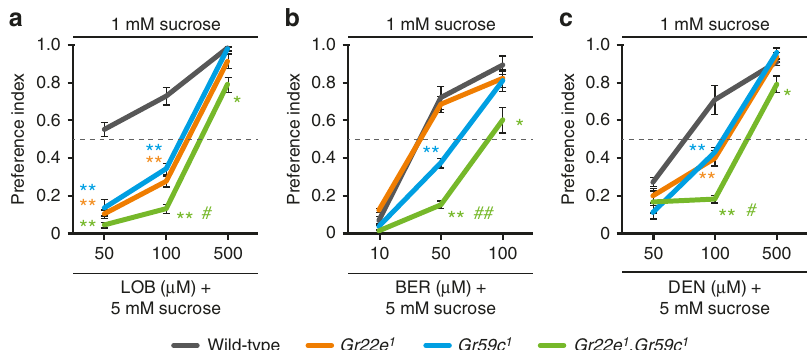
Fig. 6 The contribution of Gr22e and Gr59c to bitter food aversion. Two-way choice assays using the indicated concentrations of a LOB, b BER, and c DEN. n = 4 – 12. ANOVAs followed by Tukey post hoc tests or Kruskal − Wallis tests followed by Mann − Whitney U post hoc tests as appropriate. All data are presented as means ± S.E.M. The asterisks and sharps indicate statistically signi fi cant differences from wild-type fl ies (* p < 0.05, ** p < 0.01) and from both Gr22e 1 and Gr59c 1 ( # p < 0.05, ## p < 0.01),